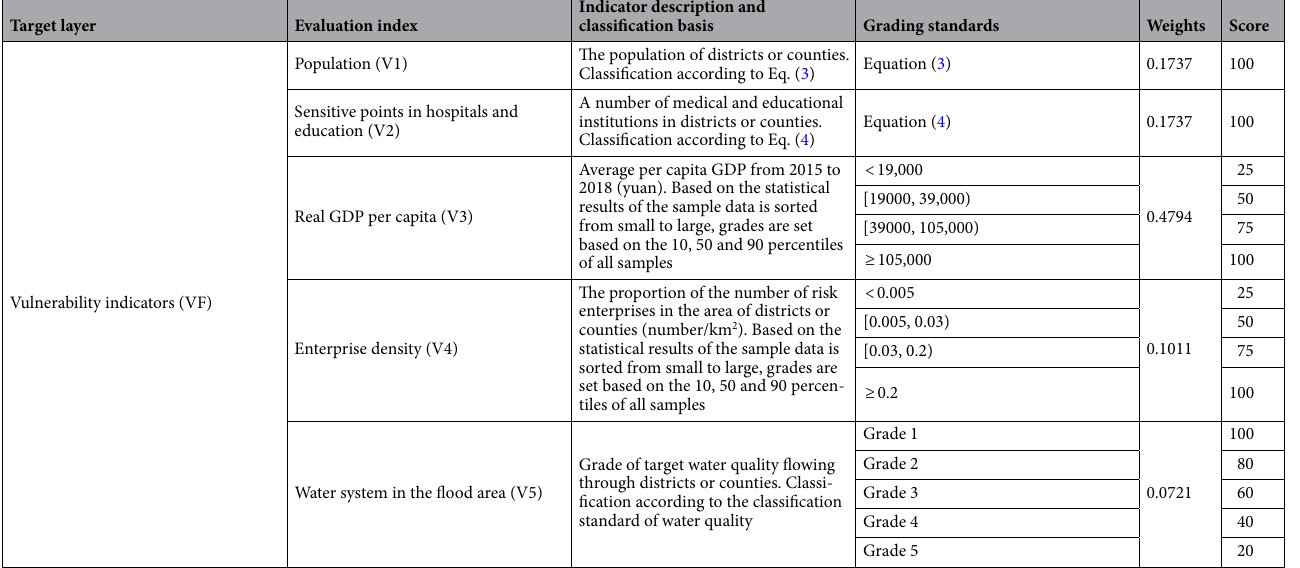
Table 1. The assessment system of Natech risk triggered by floods.